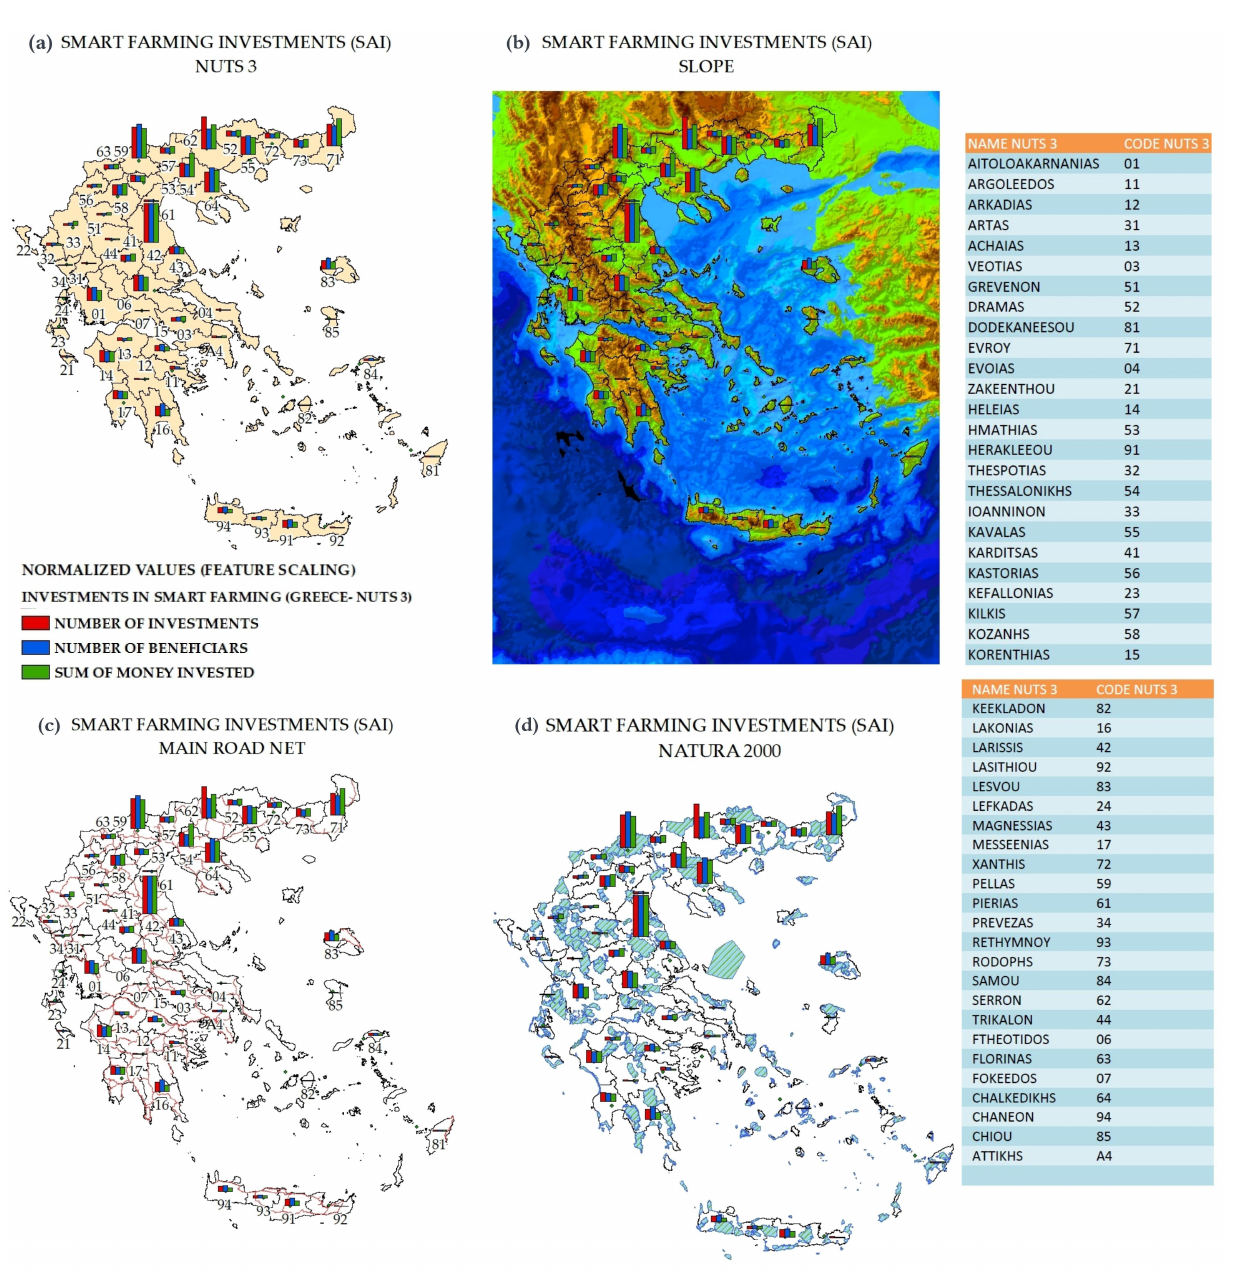
Figure 4. Bar charts of the investments made (normalization of values by feature scaling, designed own elaboration in ESRI ArcGIS Desktop 10.5 (ESRI 2016. ArcGIS Desktop: Release 10.5, Redlands, CA: Environmental Systems Research Institute), and depicted with Lusidchart own elaboration (Lusid Software Inc., Salt Lake City, UT, USA, https://lucid.app/lucidchart/ (accessed on 2 February 2023))).